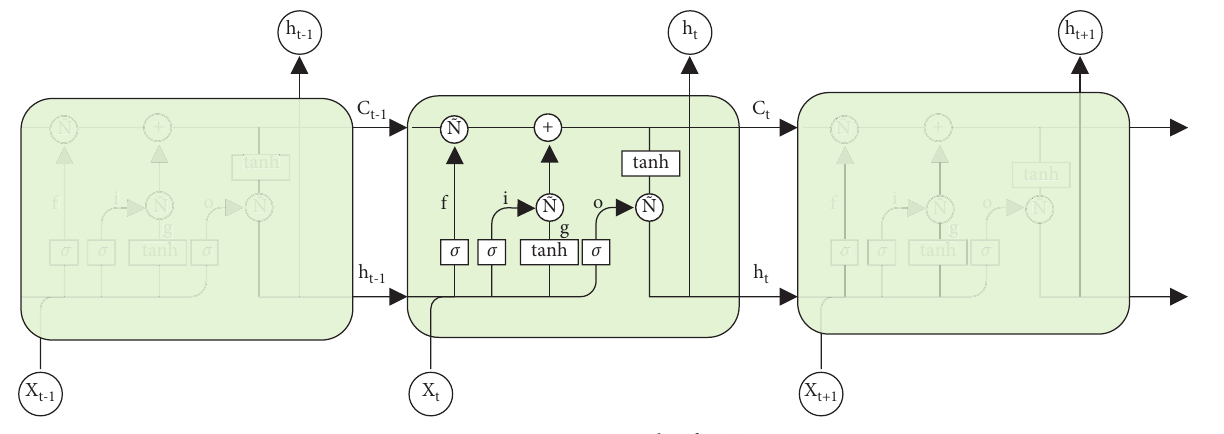
Figure 1: Basic principle of